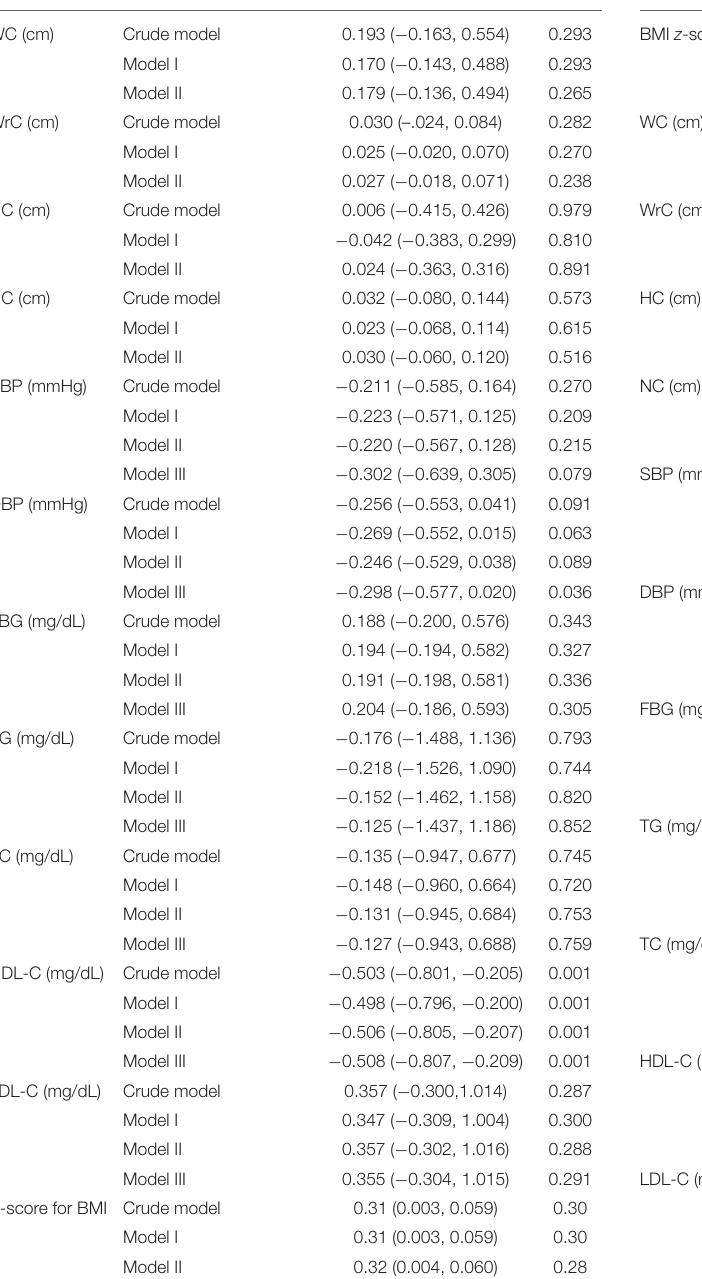
TABLE 3 | Association between serum retinol concentration ( µ mol/l) with cardiometabolic risk factors in linear regression analysis. Serum retinol concentration ( µ mol/L)